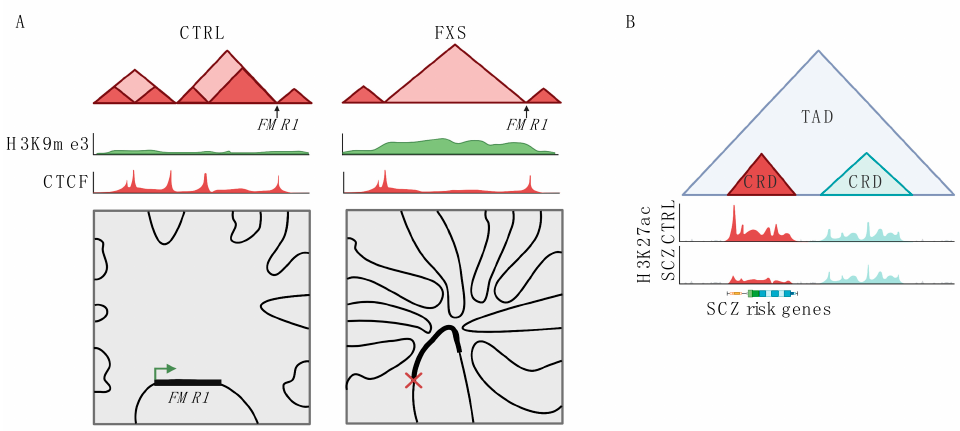
Figure 2. Changes to 3D genome structure in neuropsychiatric disease. ( A ) Schematic representation of changes to the FMR1 locus in fragile X syndrome (FXS). In FXS, normal TAD structure (shown on the left, CTRL) is disrupted. This change to TAD structure is associated with increased H3K9me3 levels and deceased CTCF binding across the disrupted region. In FXS, the FMR1 locus also has increased trans interactions with multiple other chromosomes and decreased expression. ( B ) Schematic showing changes to CRDs in schizophrenia (SCZ). Two CRDs are shown within one TAD, one of the CRDs (shown in red) has lower H3K27ac levels in SCZ as compared to health controls (CTRL). This CRD contains genes associated with SCZ risk in GWAS studies. The other CRD is unchanged in SCZ (shown in blue).